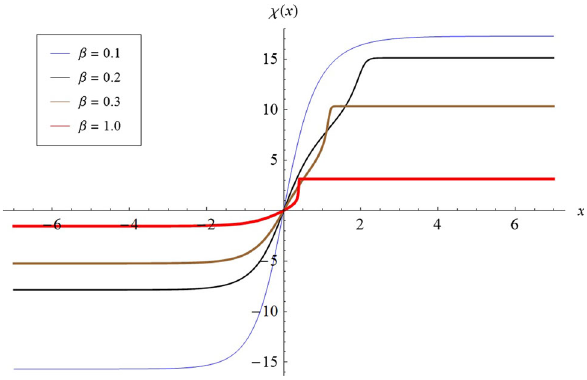
Fig. 2 Plot of the kink-like numerical solution of the Eq. (79) for α = 2, and different values of β . The thickness of the curves increases as β also increases. This solutions interpolates between the minima ¯ χ 0 and ¯ χ